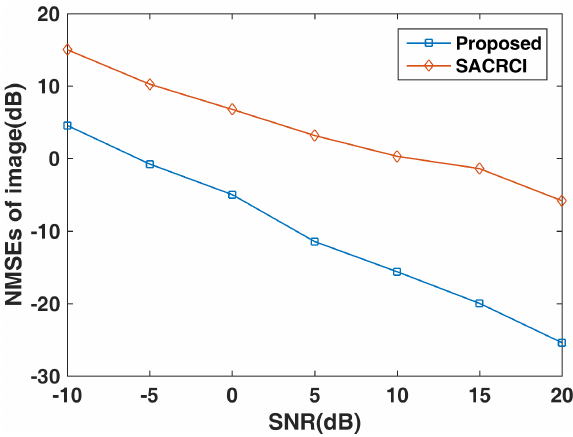
Figure 9. NMSE of target reconstructions under different SNRs.